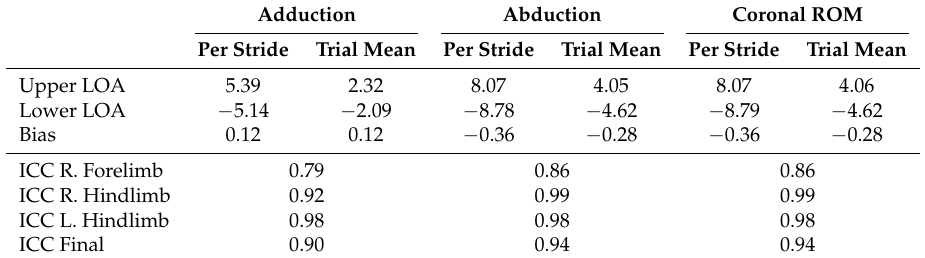
Table 6. Summary of measurement agreement statistics for the coronal limb angles at trot (values in degrees).